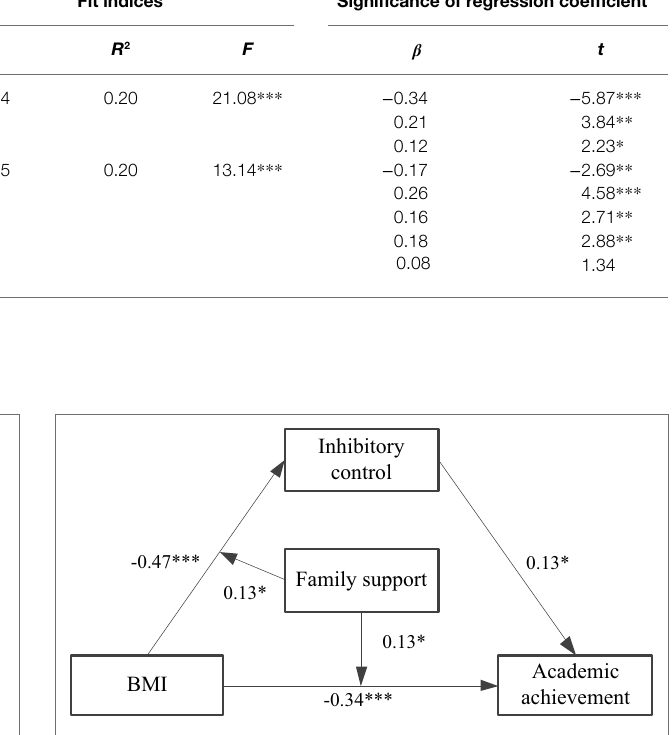
FIGURE 6 | A moderated mediation model of the family support. *The correlation is significant at the 0.05 level. ***The correlation is significant at the 0.001 level.